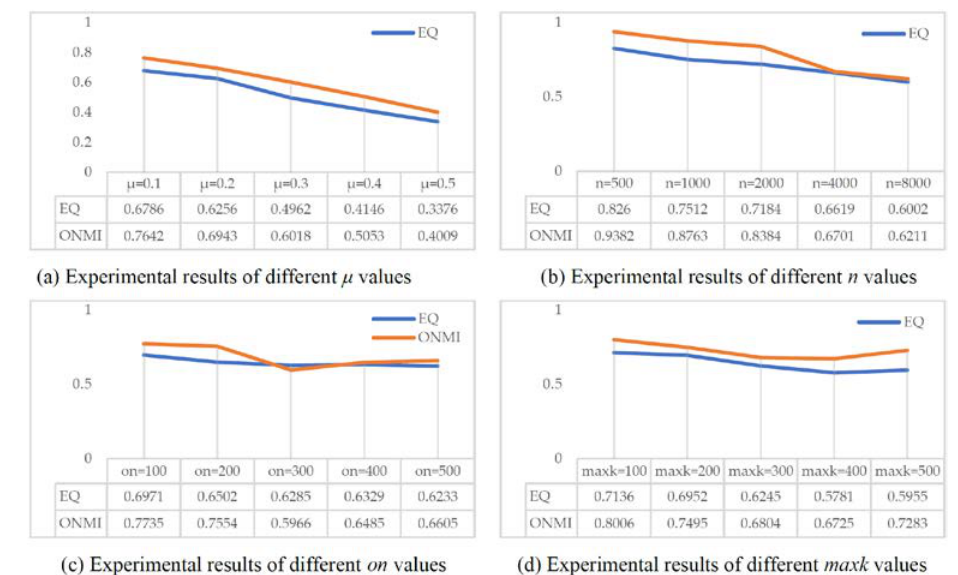
Fig. 2. Experimental results of each parameter